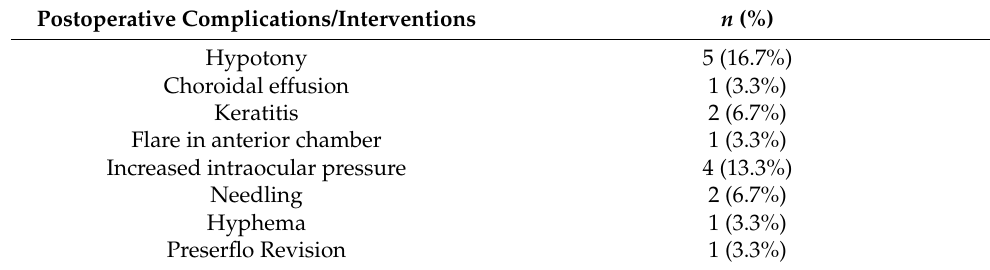
Table 5. Postoperative